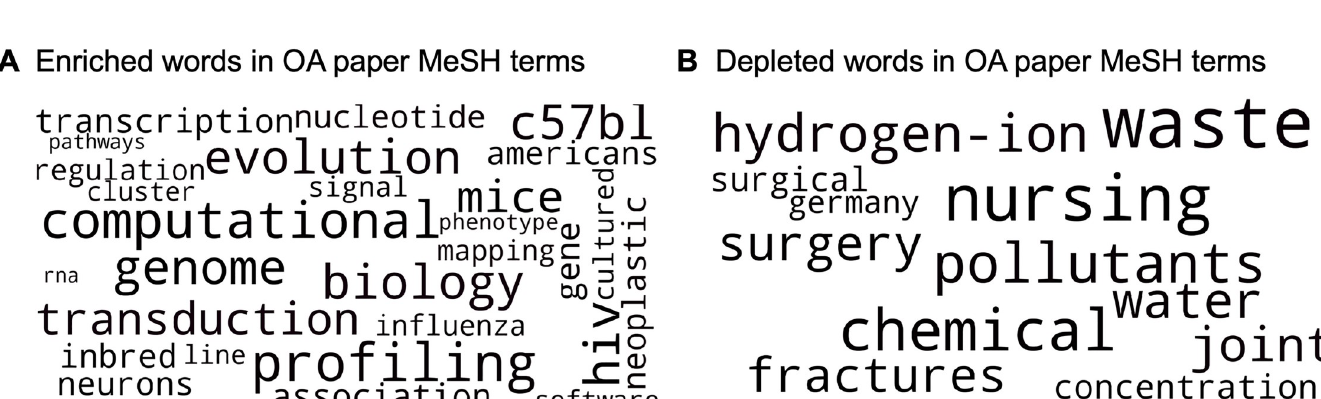
Fig 2. Enriched and depleted words in OA publications. MeSH terms were split into individual words and the total number of words were tabulated for OA and non- OA papers. Enrichment or depletion was computed from relative word frequency (the frequency of each word relative to all words within that group of papers). Words that were enriched or depleted by more than 33.3% in OA papers relative to all papers were considered for this analysis. (A) shows words that were more frequent in MeSH terms of OA papers (enriched words), while (B) shows words that were less frequent in MeSH terms of OA papers (depleted words). Enriched words were associated with computational biology, genomics, infectious diseases, and animal models, while depleted words were associated with surgery, nursing, and environmental